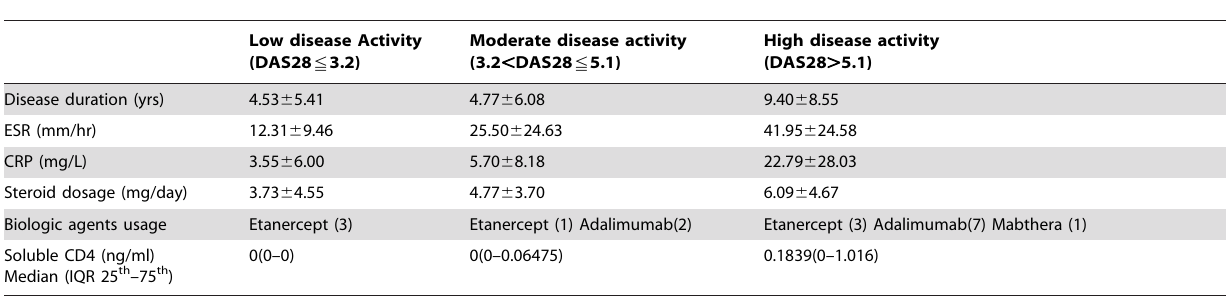
Table 2. Clinical characteristics and sCD4 levels of RA patients with low, moderate and high disease activity.